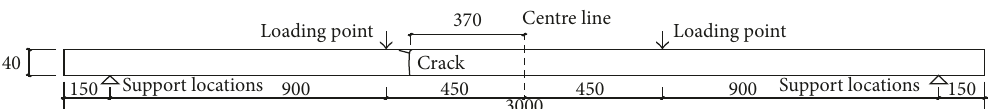
Figure 18: Crack location of GB-2 (mm).